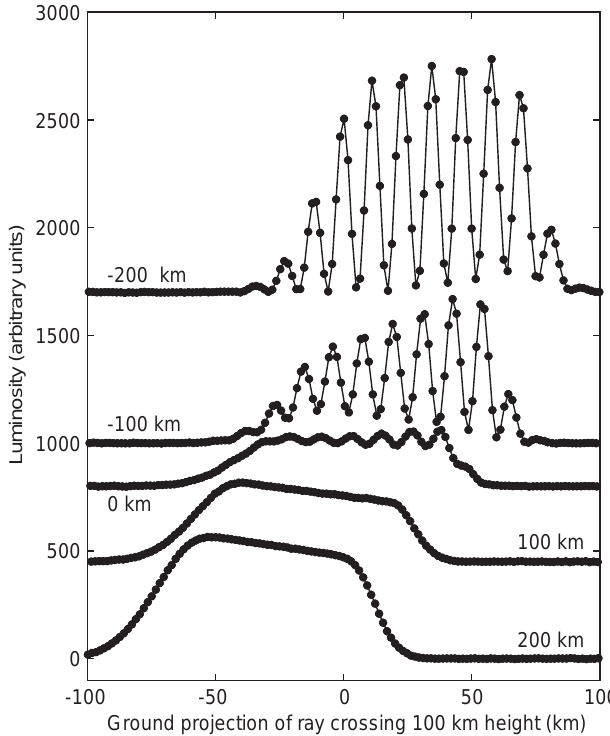
Fig. 4. Simulated airglow data for five imagers located at (cid:255) 200, (cid:255) 100, 0, 100 and 200 km on the ground level below the model in Fig. 3a. The number of data points for each imager is 600 at equal steps of the elevation angle above 10 (cid:14) . Gaussian random noise with a standard deviation of 1 unit has been added to the data. The zero level of the luminosity scale refers to the imager at 200 km; the other curves are drawn starting from di(cid:128)erent zero levels in order to avoid